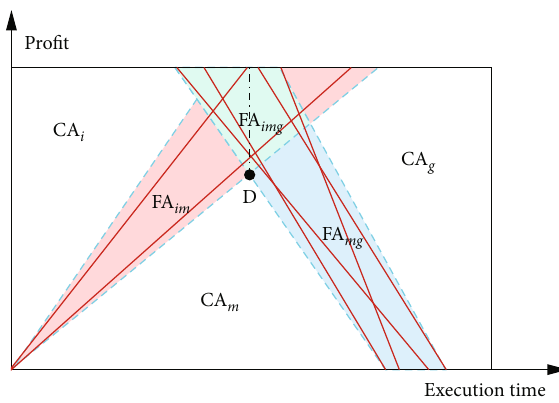
Figure 5: The areas of the mission property